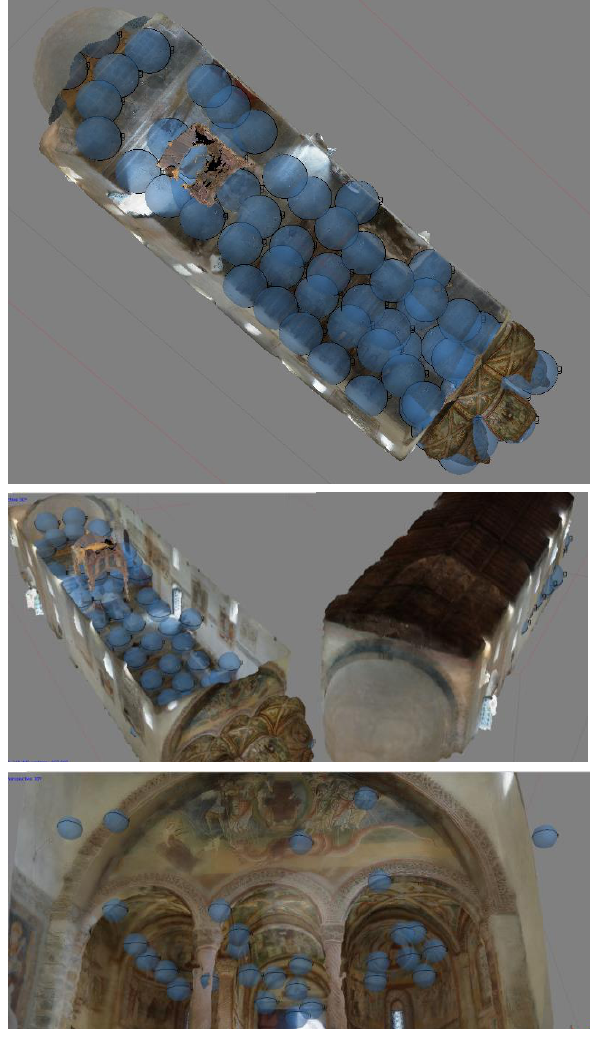
Figure 10. The interior of the Basilica of San Pietro al Monte (Italy) reconstructed with spherical images. Image acquisition required only 5 minutes, whereas data processing with PhotoScan took 3